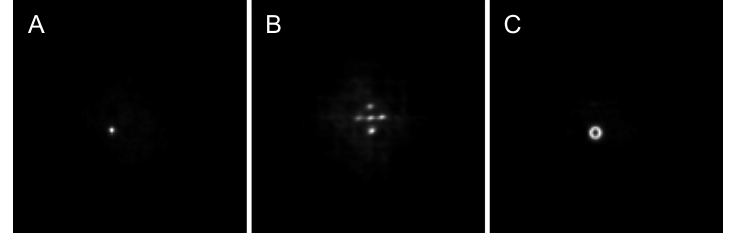
Figure 3. Decoded images (A, B, C) corresponding to the same objects used to obtain the records shown in Figure 2 (A, B, C), respectively. Decoding was done with an iterative maximum likelihood-based restoration algorithm, with 15 iterations. Note how the background is greatly reduced when compared with the decoded images shown previously (Figure 2 D, E, F). For the point-like source, a resolution of 1.66 mm (full-width at half-maximum) was obtained.